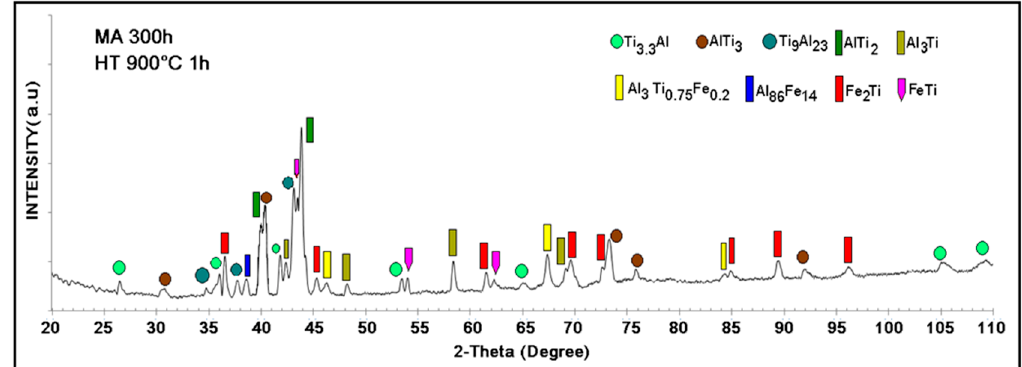
Figure 2. XRD results of the Al 43 Ti 36 Fe 21 system obtained by mechanical alloying for 300 h and heat-treated at 900 ◦ C for one hour. Table 1. Crystallographic data of the initial